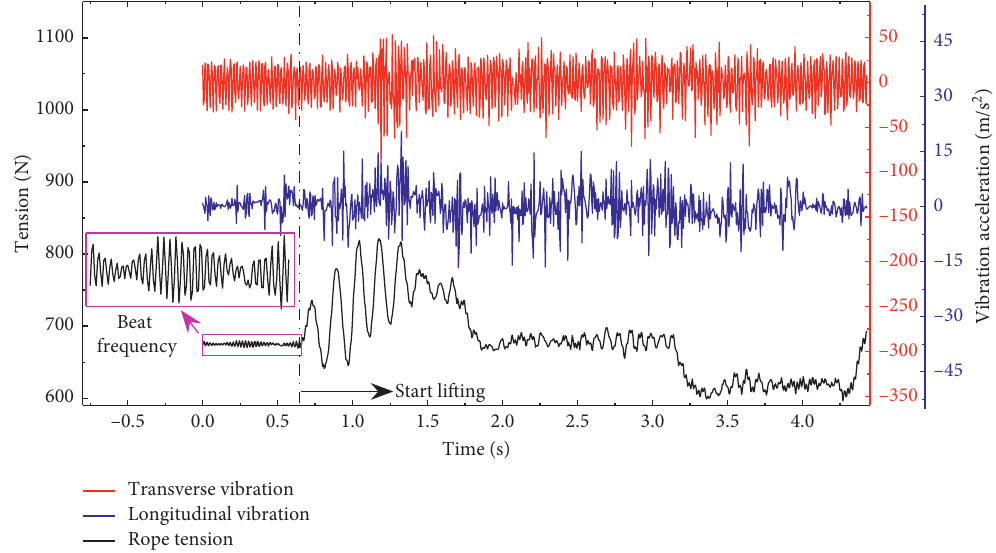
Figure 10: Rope tension and vibration under 46.7Hz longitudinal excitation.